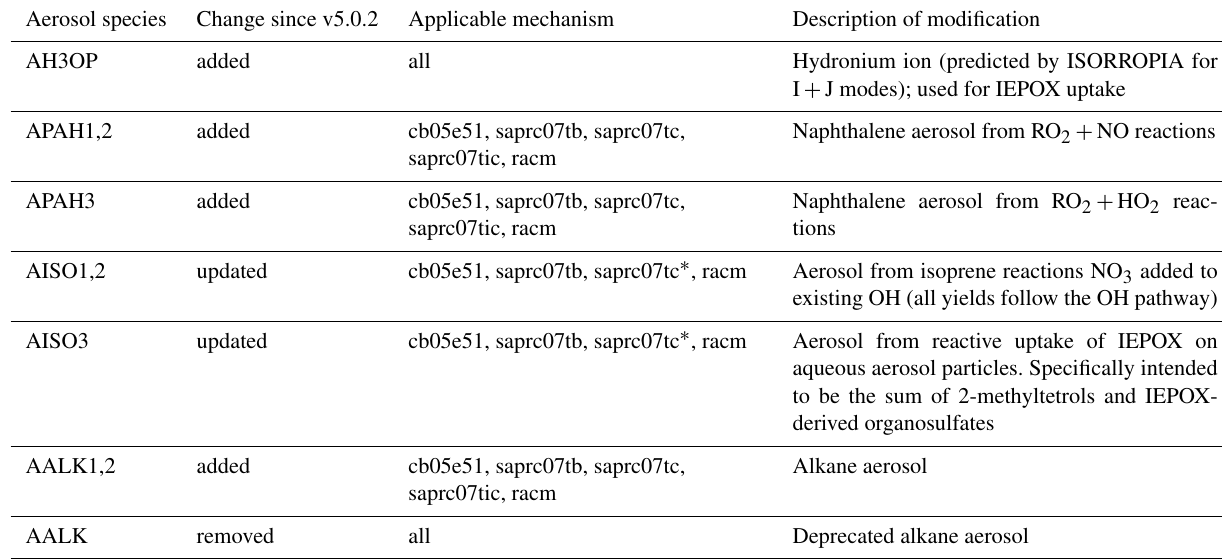
Table 1. New and revised SOA species in the CMAQv5.1 AERO6 mechanism. Aerosol